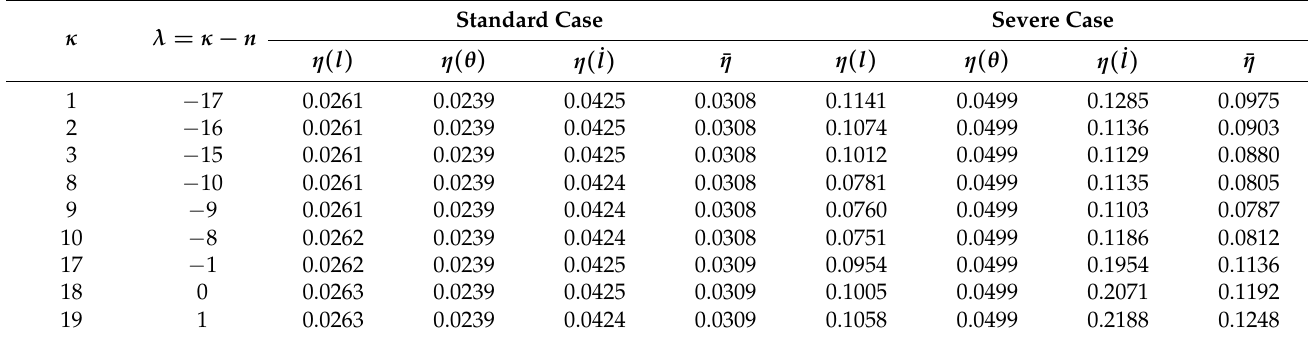
Table 4. Accuracy test results of the UT methods with different tuning factors.